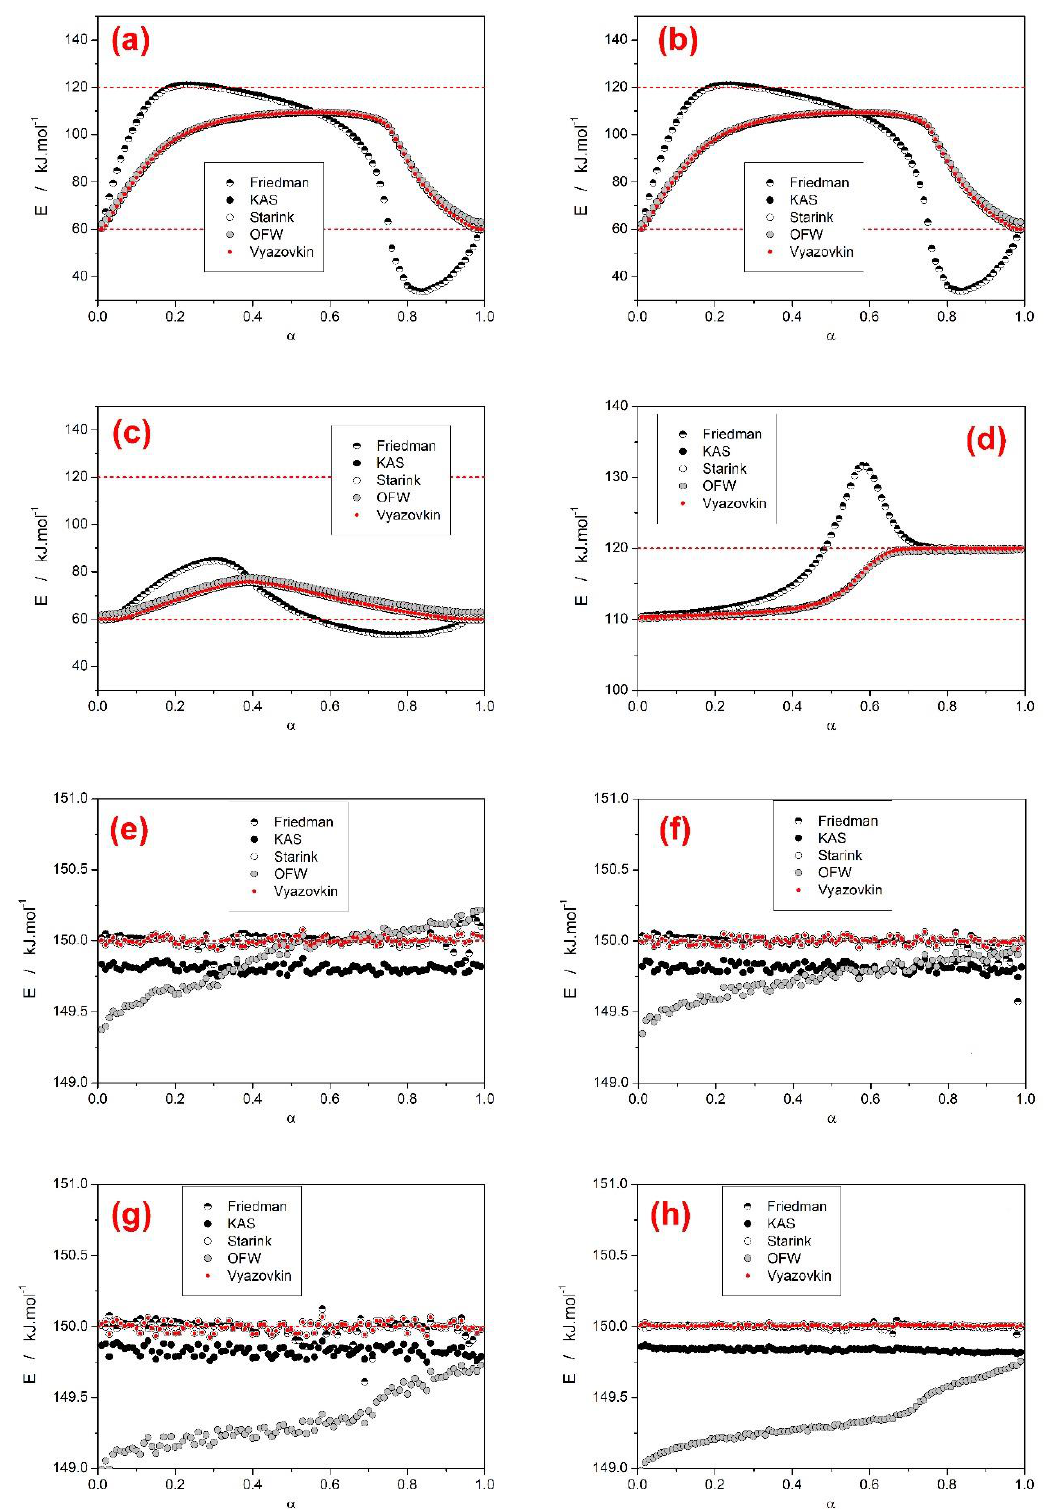
Figure 4. Results of the Friedman, KAS, Starink, OFW, and Vyazovkin analyses applied to the datasets A, B, C, D, E, and G (group 1) simulated with the 10,000 points / curve density. Results for datasets A and G are also shown for simulations with 50,000 points / curve density. The horizontal red dashed lines in each graph represent the true E 1 and E 2 values input into the simulations. ( a ) set A, 10 k; ( b ) set A, 50 k; ( c ) set B, 10 k; ( d ) set C, 10 k; ( e ) set D, 10 k; ( f ) set E, 10 k; ( g ) set G, 10 k; ( h ) set G, 50 k.